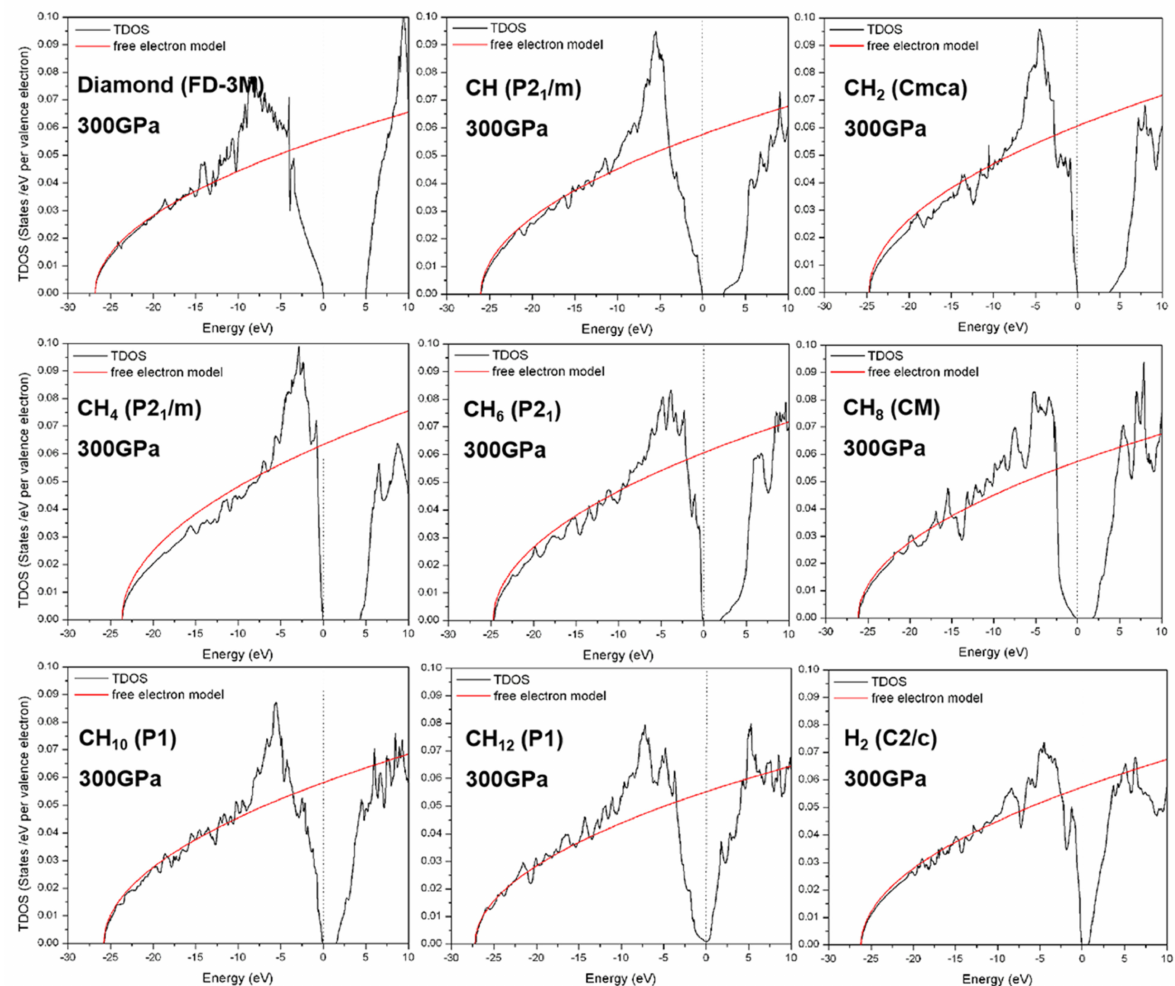
Figure 4. Computed total density of states of diamond, H 2 , and CH n (n = 1, 2, 4, 6, 8, 10, and 12) phases at 300 GPa. The free electron models are